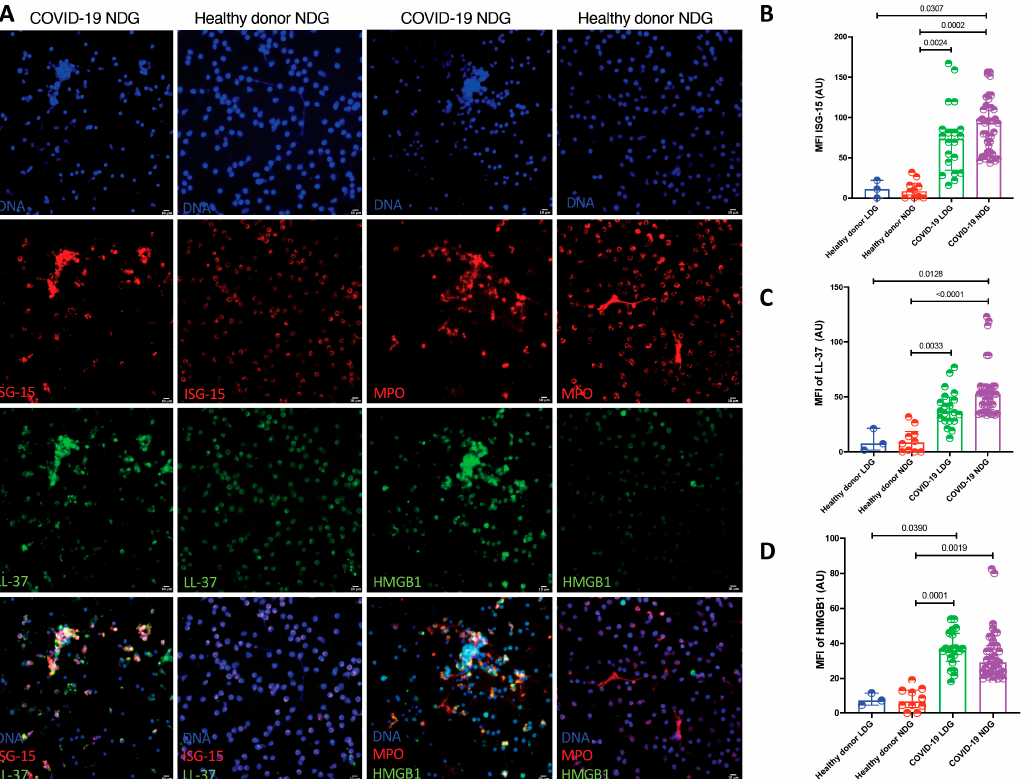
Figure 3. LDG and NDG from COVID-19 patients carry a distinctive pro-inflammatory protein cargo. ( A ). Representative confocal microscopy image showing a higher expression of ISG-15, LL-37 and HMGB1 in NDG NETs from patients with COVID-19 in comparison to healthy donors. ( B – D ). Cumulative statistics show a higher MFI of ISG-15, LL-37 and HMGB1 in LDG ( n = 20) and NDG ( n = 18) NETs from COVID-19 patients in comparison to NETs from healthy donors LDG ( n = 3) and NDG ( n = 10). Differences among medians were addressed with the Kruskal–Wallis test and the multiple comparison Dunn’s test.